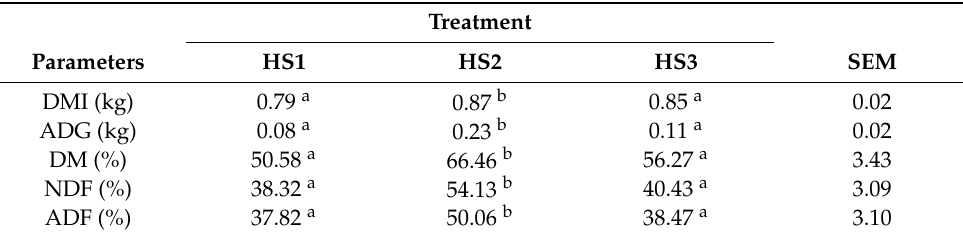
Table 6. The growth performance parameters of the heat-stressed goats supplemented with Clostrid- ium butyricum